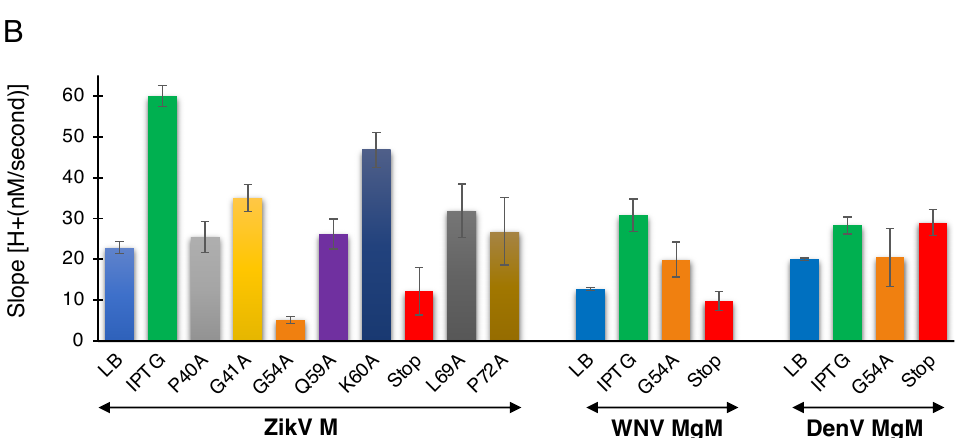
Figure 3. Proton conductivity of flavivirus viroporins and mutants thereof. Wild-type ZikV-M, WNV MgM, DenV MgM, and mutants were transformed into bacteria that harbor a pH-sensitive green fluorescence protein [37,38]. Proton flow for uninduced wild type, induced wild type, and mutants (100µM IPTG) were recorded after two hours of induction. Panel ( A ) depicts the H + concentration change as a function of time, while the slopes of the individual curves are listed in panel ( B ).